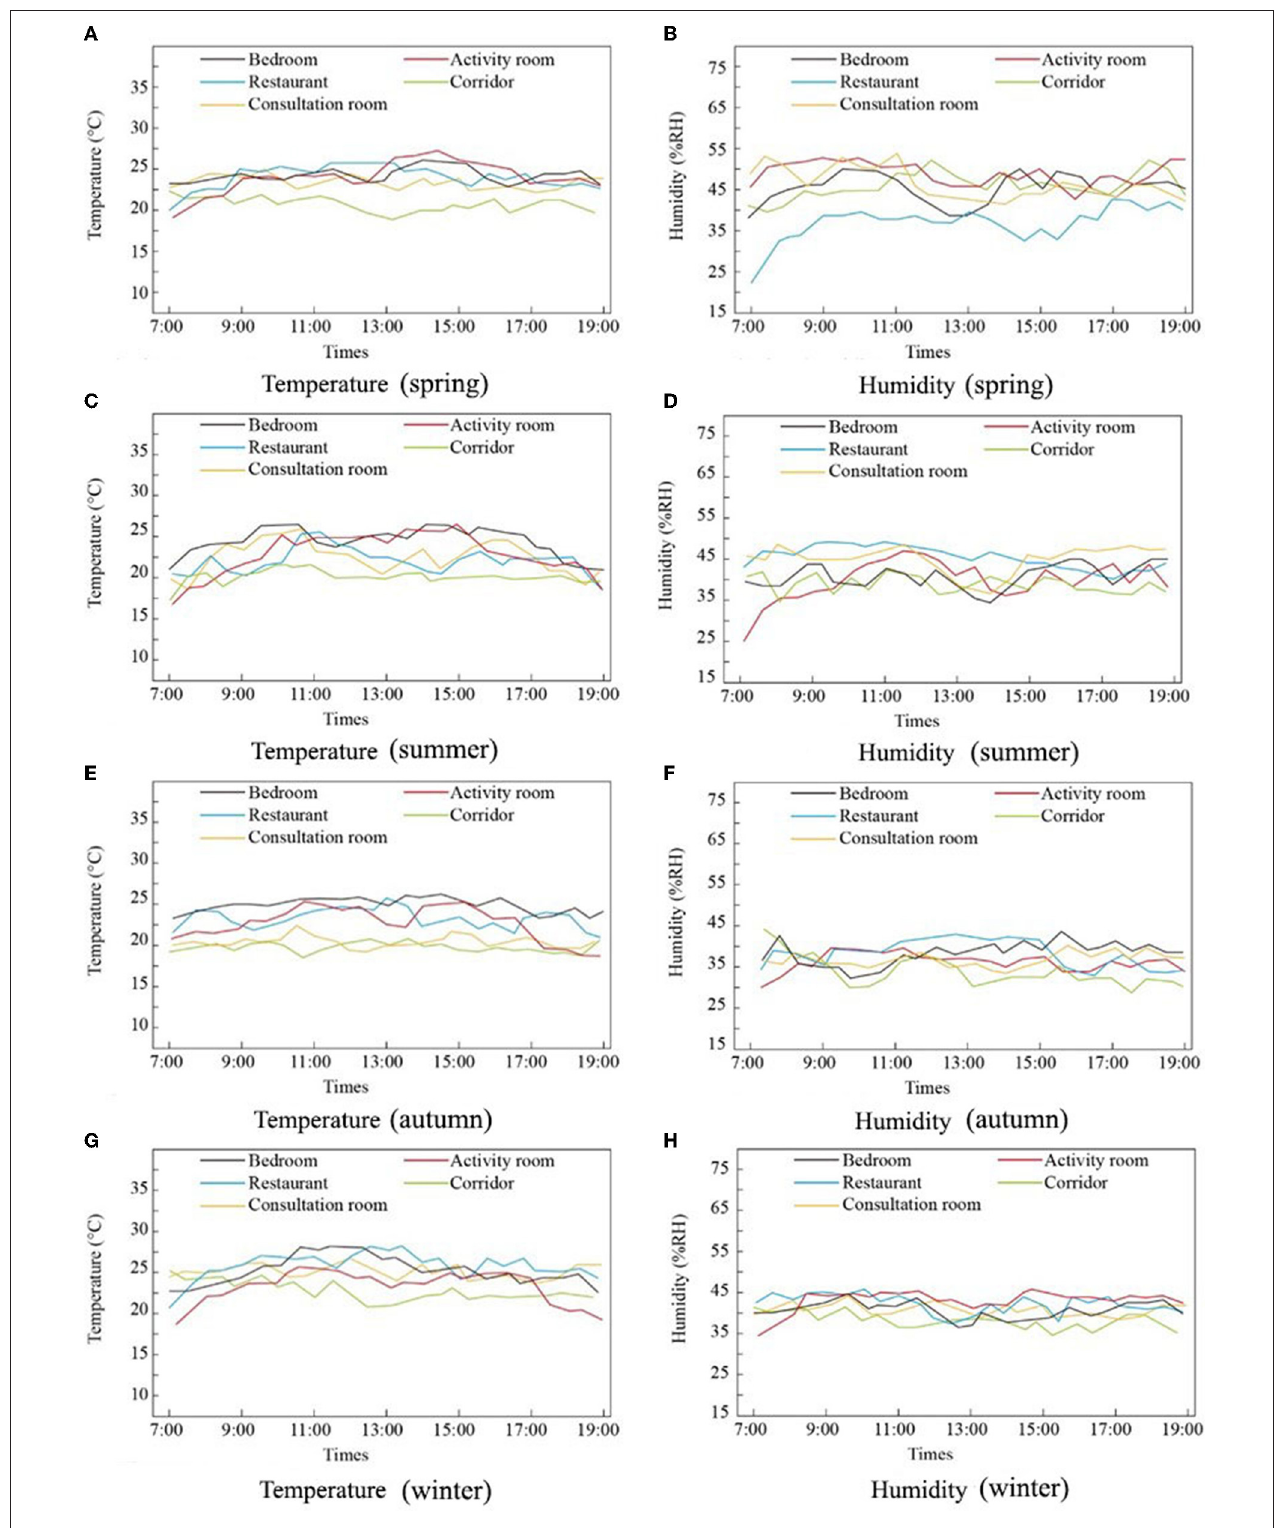
FIGURE 8 | Temperature and Humidity measurement in different seasons and different rooms. (A) Temperature (spring), (B) Humidity (spring), (C) Temperature (summer), (D) Humidity (summer), (E) Temperature (autumn), (F) Humidity (autumn), (G) Temperature (winter), and (H) Humidity (winter).